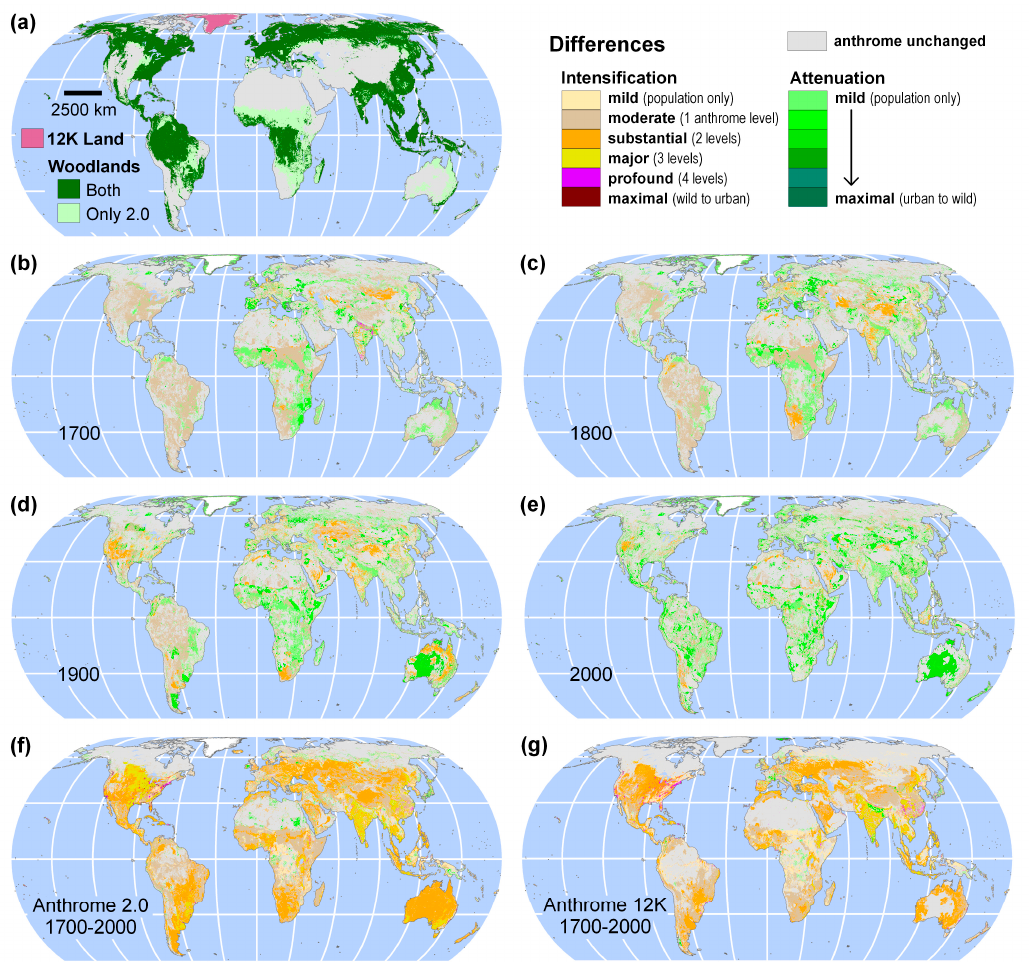
Figure 1. Di ff erences between Anthromes 12K and Anthromes 2.0 maps. ( a ) Di ff erences in land mask (“12K Land”) and woodland cover, illustrating overlap between woodland cover maps (“Both”), and areas with woodland cover only in Anthromes 2.0 (“2.0”). Di ff erences in years ( b ) 1700, ( c ) 1800, ( d ) 1900 and ( e ) 2000 CE. Di ff erences are highlighted in terms of relative intensification or attenuation of anthrome use class in Anthromes 12K. Intensification indicates shifts in anthrome level towards dense settlements and away from wildlands and shifts within anthrome levels (“mild”) towards higher land use intensity (irrigation) and / or population density. Attenuation highlights shifts in the opposite direction, towards less intensive use and less dense populations within anthromes. Long-term changes between 1700 and 2000 CE in ( f ) Anthromes 2.0 and ( g ) Anthromes 12K are highlighted using the same legend. Eckert IV